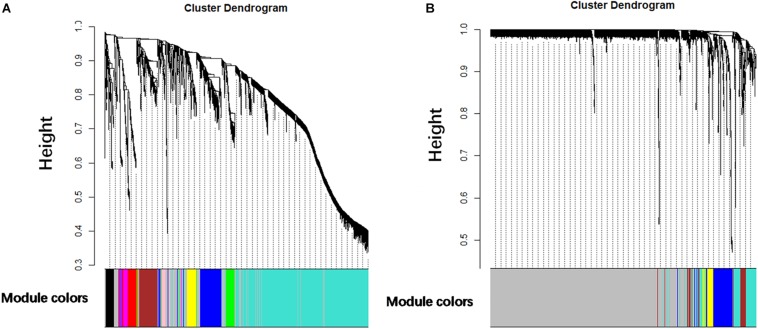
Clustering dendrograms. (A) Clustering dendrograms of genes based on a dissimilarity measure (1-TOM). (B) Clustering dendrograms of miRNAs based on a dissimilarity measure (1-TOM).